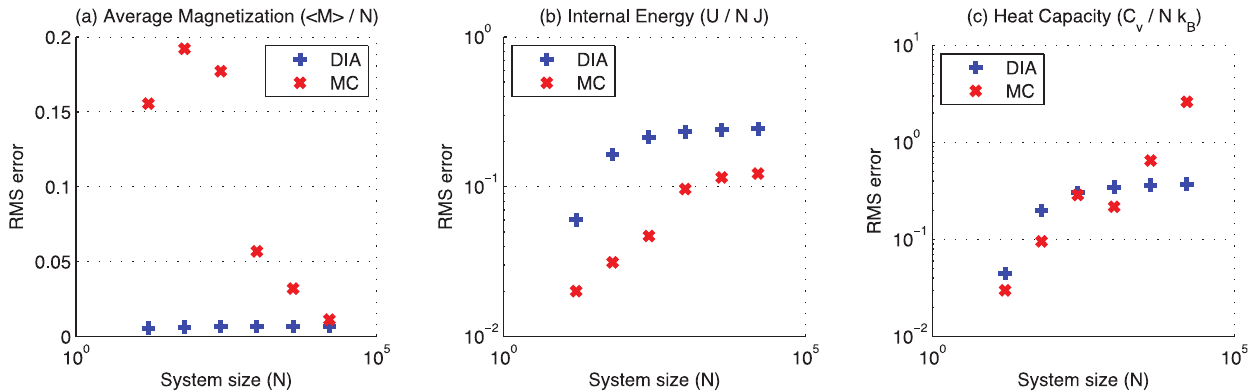
Figure 4. Accuracy as a function of system size. Accuracy for the direct interaction algorithm (DIA) and the Metropolis Monte Carlo (MC) method as a function of system size N (log-log scale). Accuracy is calculated as the RMS error relative to the exact value. The number of steps is chosen such that the computation time for the MC method is at least 10 times the computation time for the DIA (Table 1).